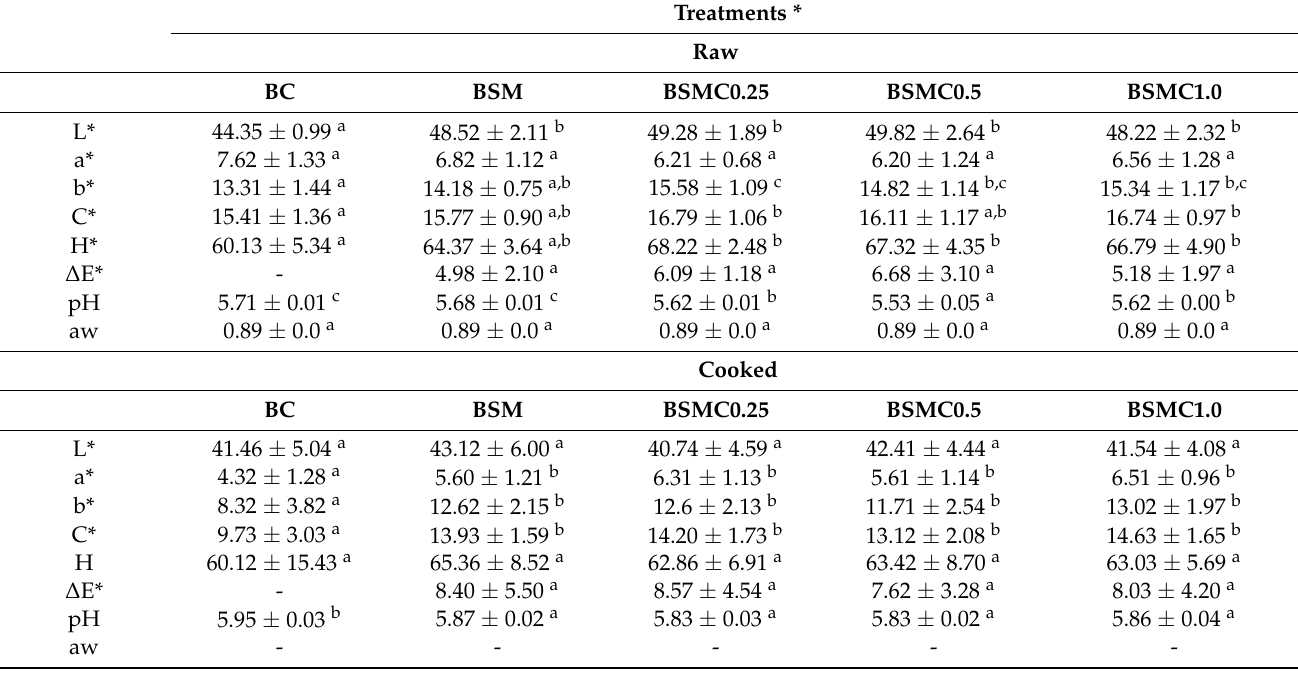
Table 7. Effect of partial substitution of pork backfat by a gelled emulsion of maca flour, soybean oil, and chincho essential oil on the color, pH, and Aw parameters of raw and cooked beef burger. Treatments * Raw BC BSM BSMC0.25 BSMC0.5 BSMC1.0